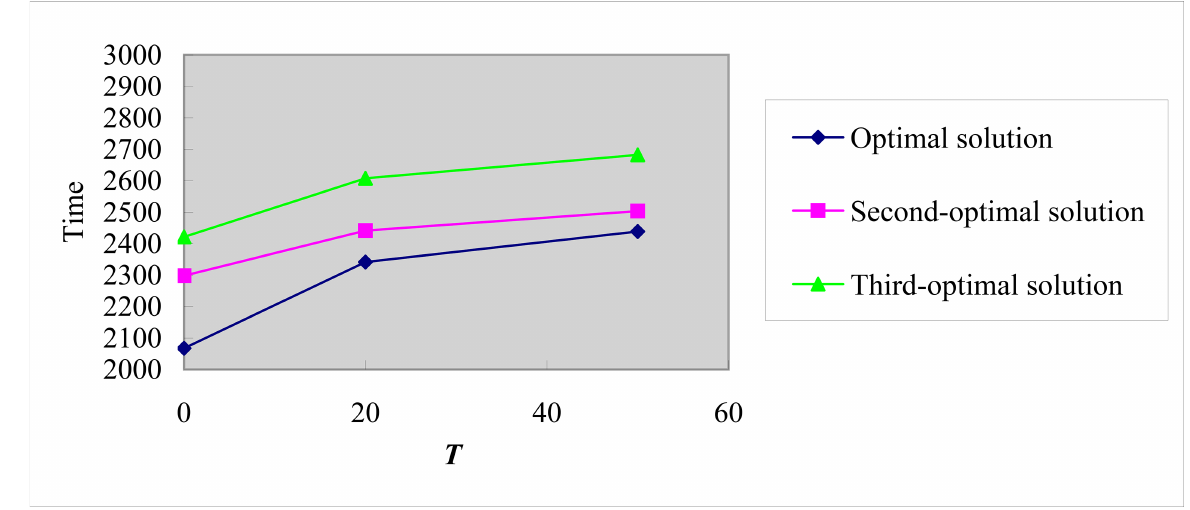
Fig 7. Total distribution time of solution set with different